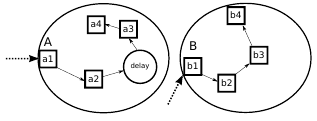
Figure 7: Two models with processes started by the environ- ment. Process A has a special action, delay In A , there is a special action, delay which is where composition would occur. In an uncomposed executing model, this stops the process for a period of time before continuing. When composed, the process looks like Figure 8. The sequence of actions is now